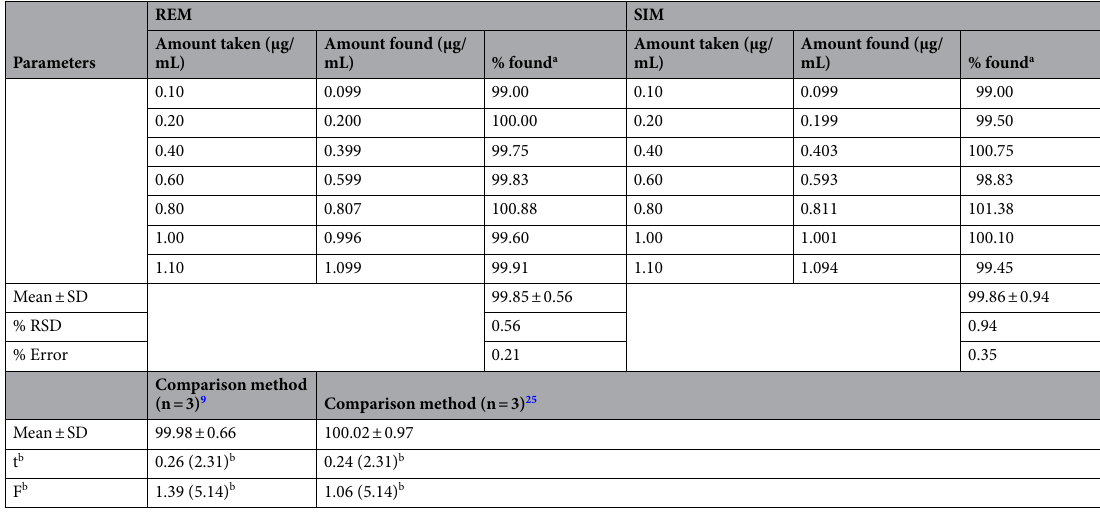
Table 2. Application of the proposed method for the determination of the studied drugs in their raw materials. a Average of 3 replicate determinations. b The values between parentheses are the tabulated values of t and F at P = 0.05 43 .